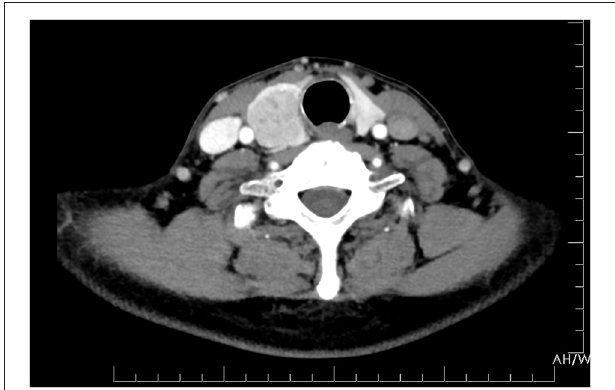
FIGURE 1 | Ultrasound sonogram of the thyroid showed a non-homogenous mass with an unclear boundary, low and moderate echo and rich blood flow signal (A) . Enlarged lymph nodes were found in the right neck (B)